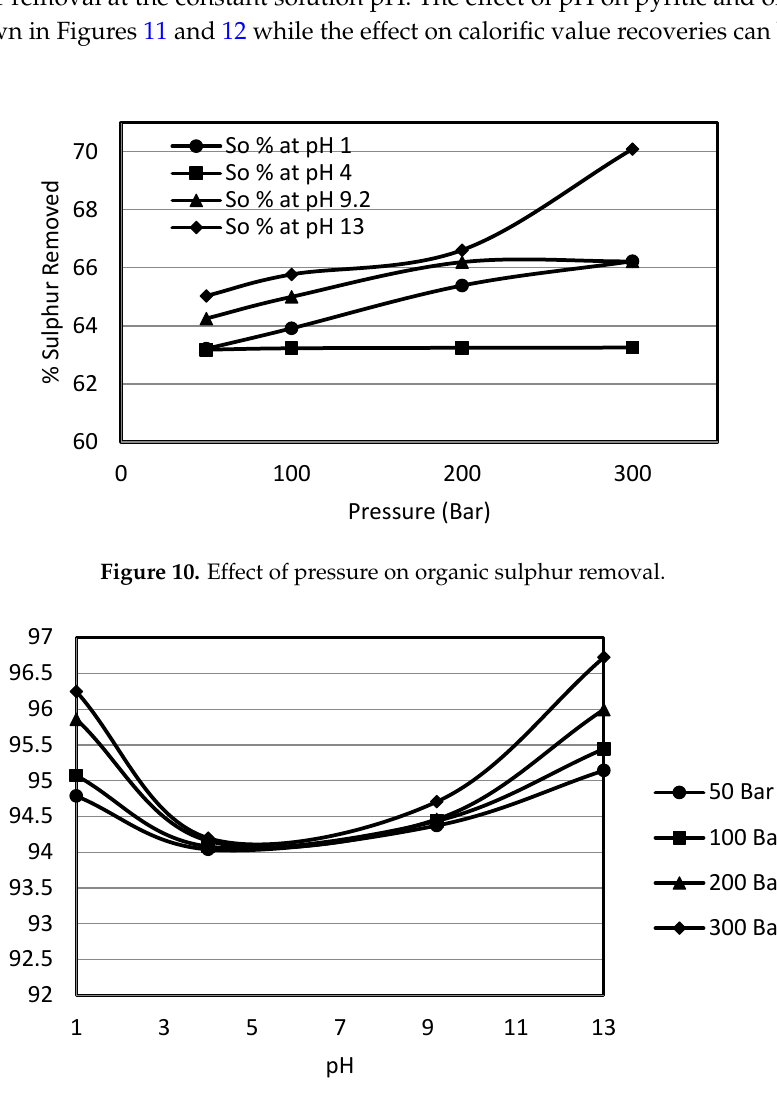
Figure 11. Effect of pH on pyritic sulphur removal.